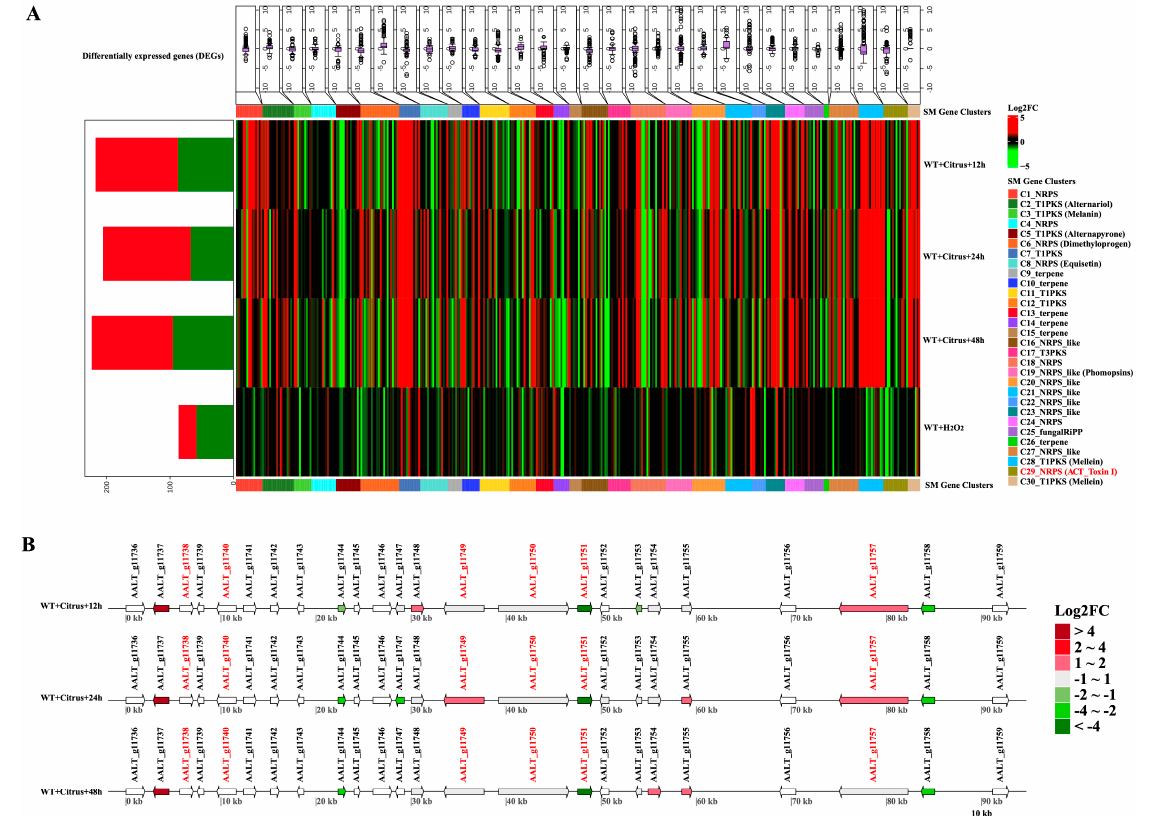
Figure 7. Multiple critical SM gene clusters were regulated in Alternaria alternata during infection. ( A ) The gene expression pattern of SM gene clusters in A. alternata when it was inoculated on citrus leaves for 12 h, 24 h, 48 h and A. alternata under oxidative stress (H 2 O 2 ) was compared to that of A. alternata under the growth stage. The genes were represented in different colors to indicate their differential expression levels in the different treatments compared to the A. alternata under the growth stage. These included polyketide synthases (pks), nonribosomal peptide synthetases (nrps), Type1 (t1), putative biosynthetic types (cf_putative) and terpene synthetase (terpene). ( B ) The gene expression pattern of the ACT toxin gene cluster of A. alternata inoculated on citrus leaves for 12, 24, and 48 h was also compared to that of A. alternata under the growth stage. The text in red represents the core gene of the secondary metabolite gene cluster.